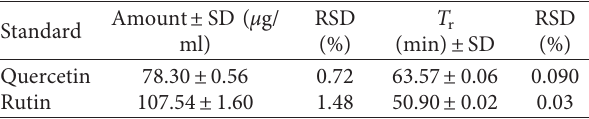
Table 6: Repeatability of standard quercetin and